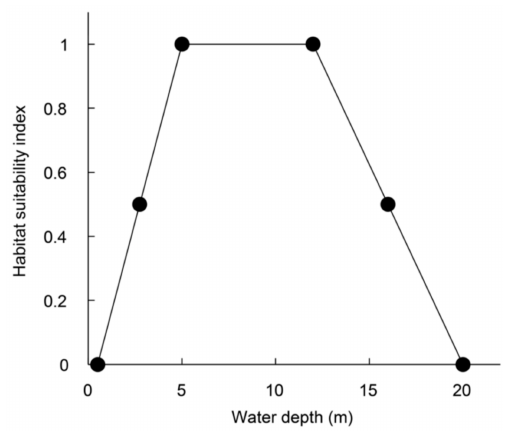
Figure 12. Coupled depth suitability index curve.